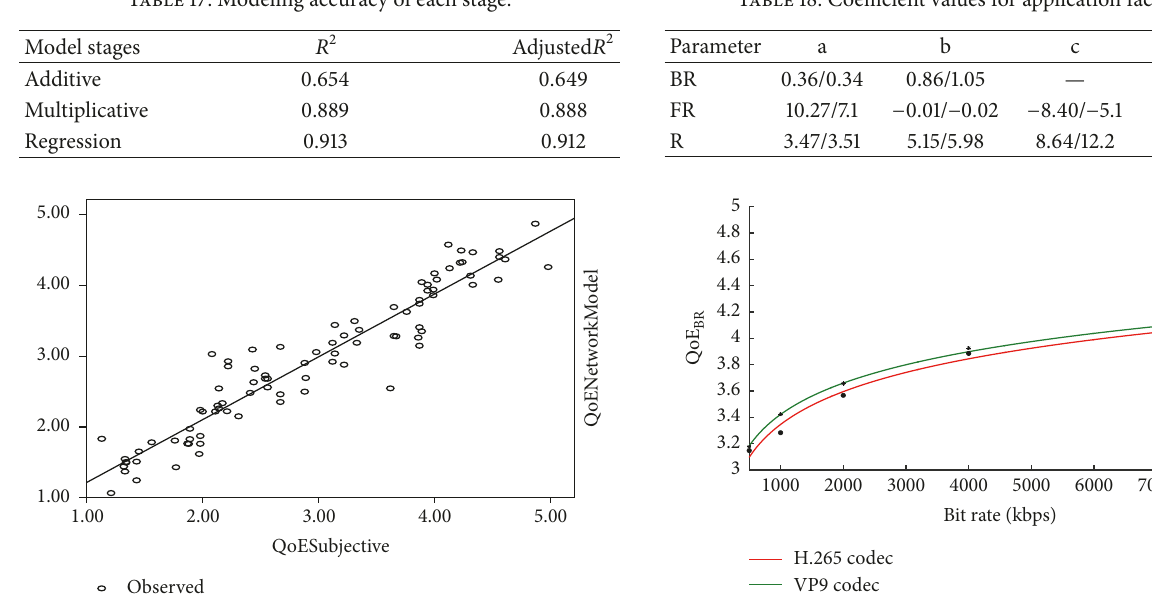
Figure 13: Relationship between bit rate (Kbps) and QoE subjective test).